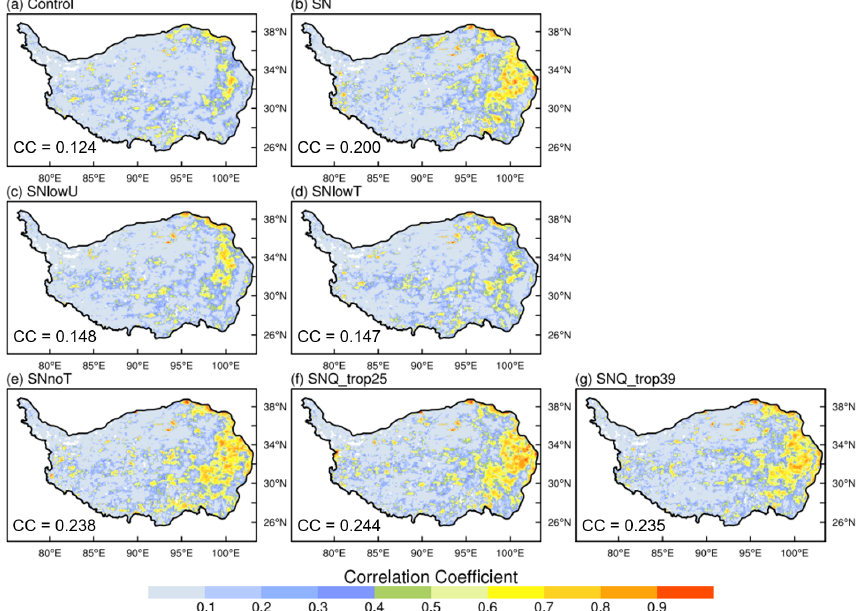
Figure 3. Spatial distribution of the temporal correlation between CMORPH and (a) control, (b) SN, (c) SNlowU, (d) SNlowT, (e) SNnoT,